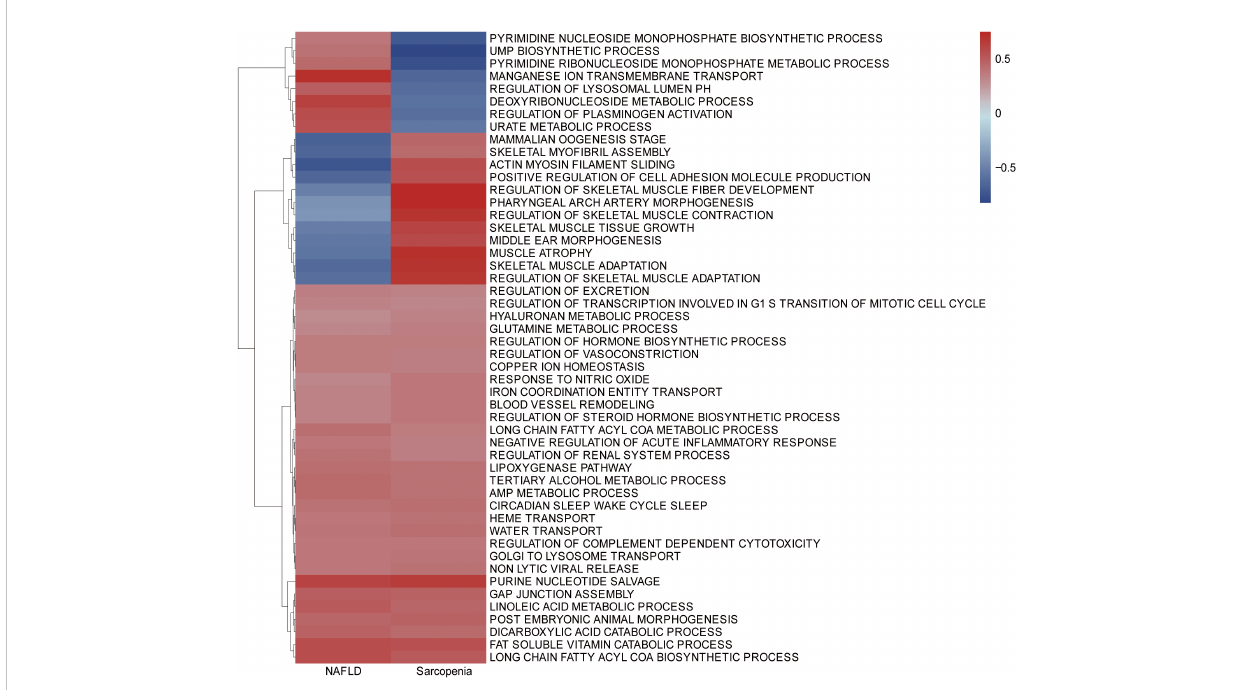
FIGURE 3 Gene Set Variation Analysis (GSVA) in NAFLD and Sarcopenia. GSVA of top 1000 genes in NAFLD and Sarcopenia.